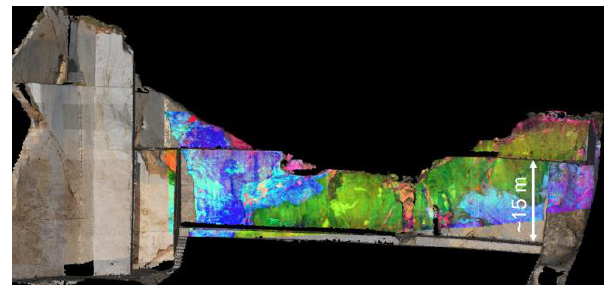
Figure 2. Terrestrial lidar model multi-textured with RGB photographs and hyperspectral material distribution